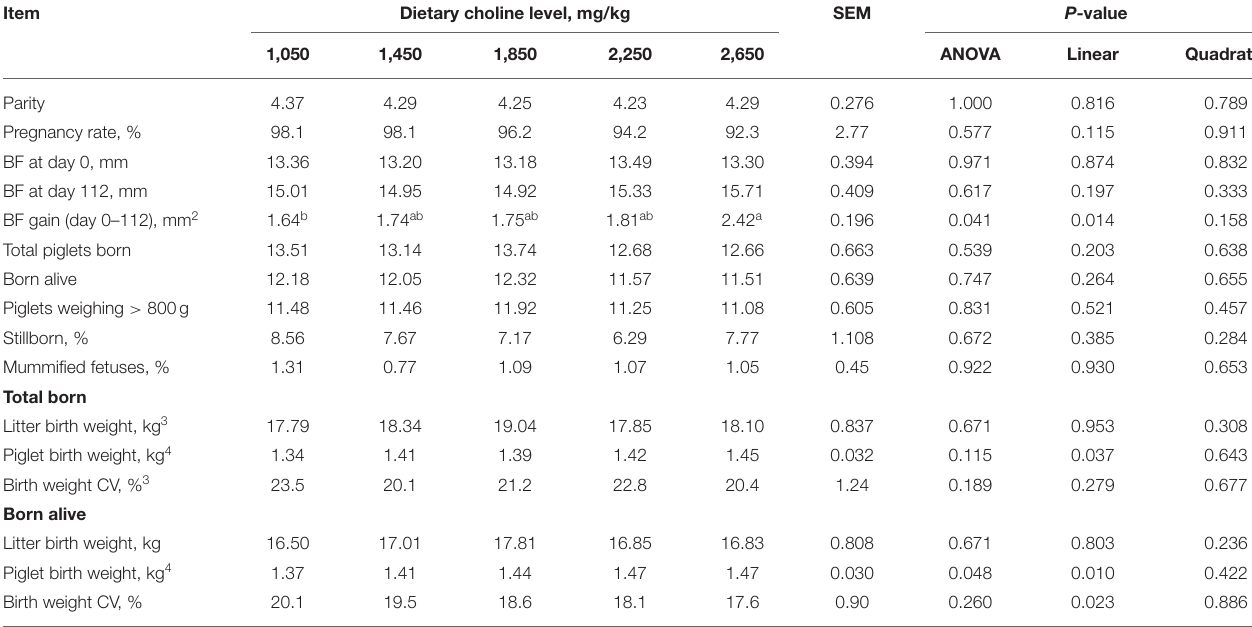
TABLE 2 | Effect of dietary choline levels during gestation on sow reproductive performance 1 . Item Dietary choline level, mg/kg SEM P -value